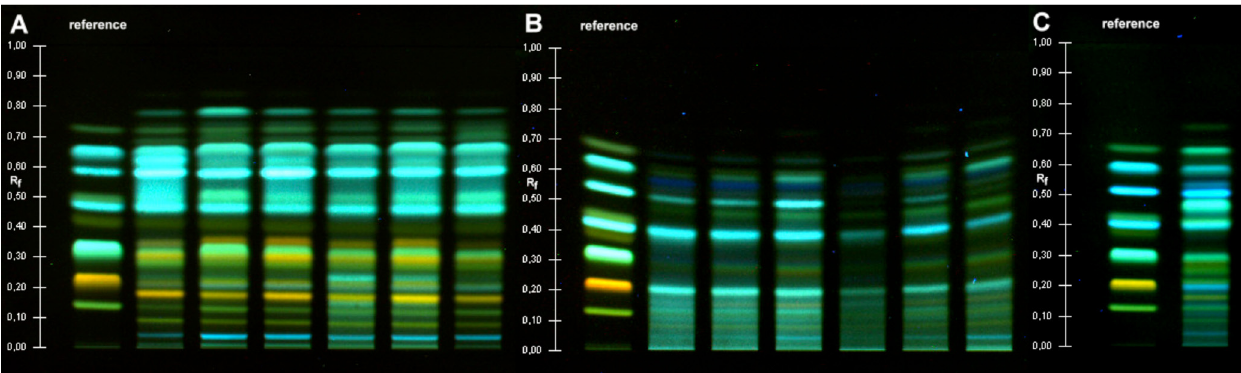
Fig. 2: TLC fingerprints of (A) O-type propolis samples with characteristic light blue, green and yellow bands, (B) of B-type samples with light and dark blue colors and (C) of G-type propolis with additional green bands. Applied volume for each propolis sample was 10 μL and 25 μL for the reference mixture,